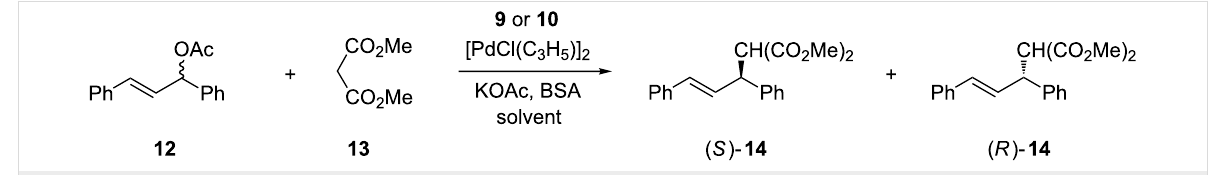
Scheme 3: Palladium catalyzed allylic